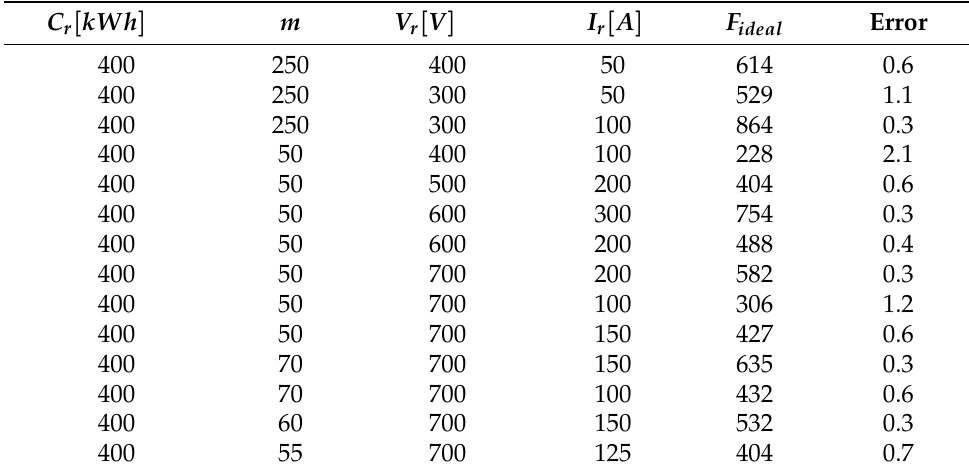
Table 8. CS input parameters